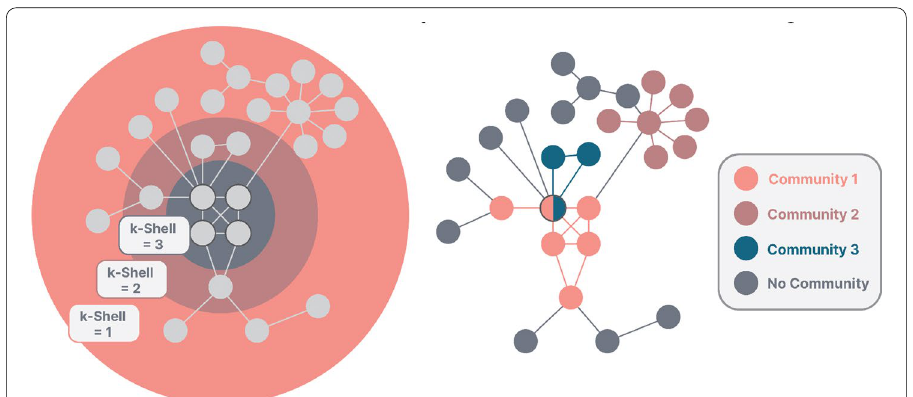
Fig. 1 On the left, an example from Kitsak et al. (2010) can be seen. Nodes within the core of the network, i.e. with a high k -Shell index, were found to be good spreaders. On the right, the same network is shown, but clustered with the Link Communities approach by Ahn et al. (2010). Nodes with grey borders are nodes which are hypothesized to exhibit a high spreading